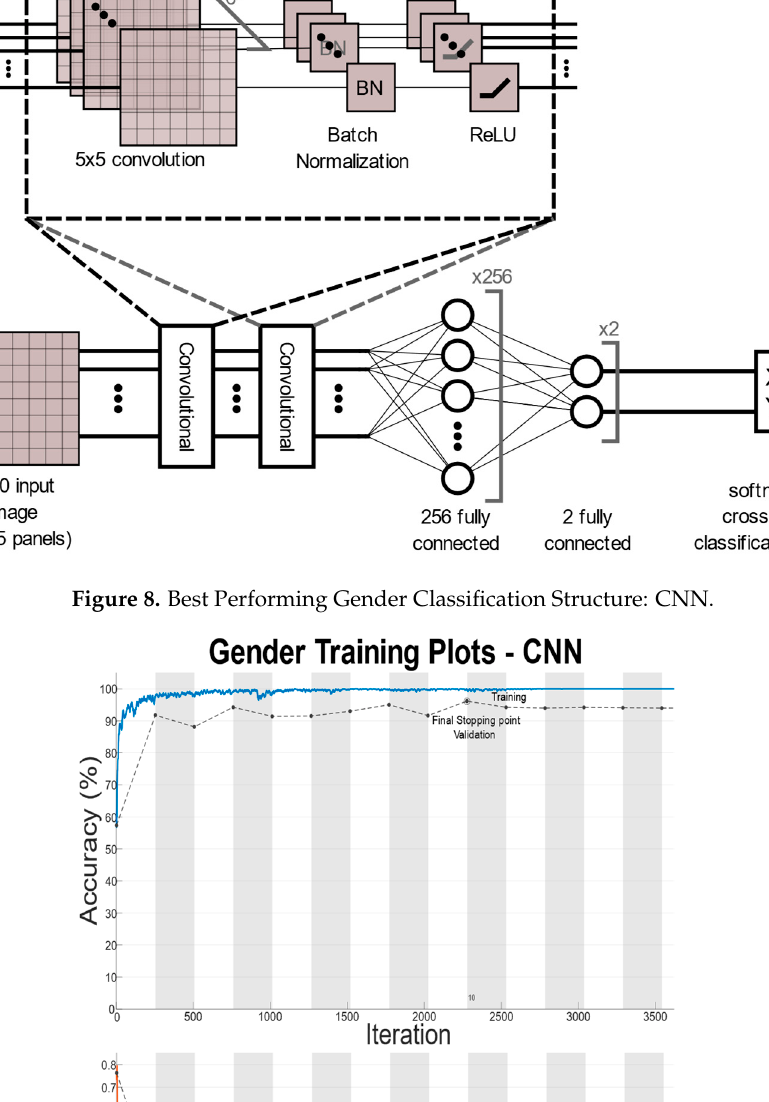
Figure 7. Training Plot for Best Performing Identity Network.